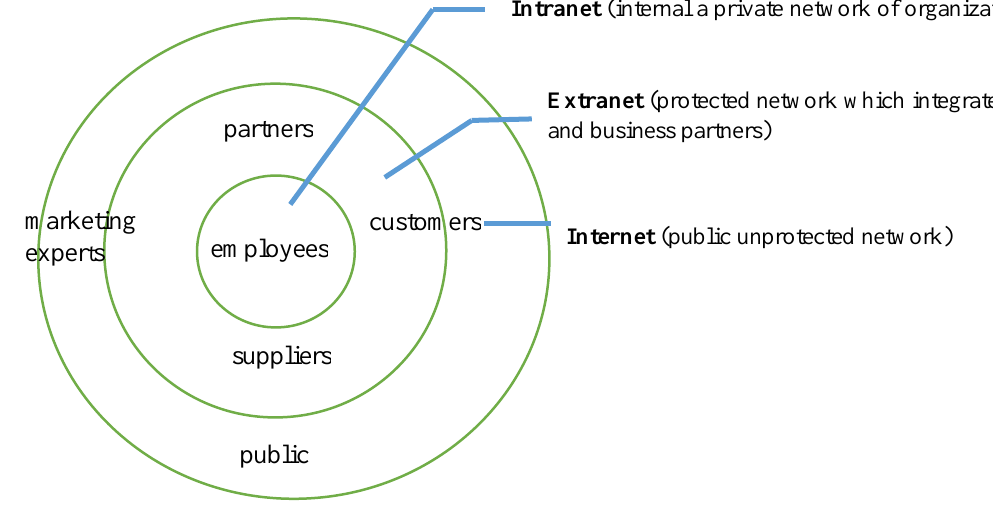
Fig. 1. Informational networks